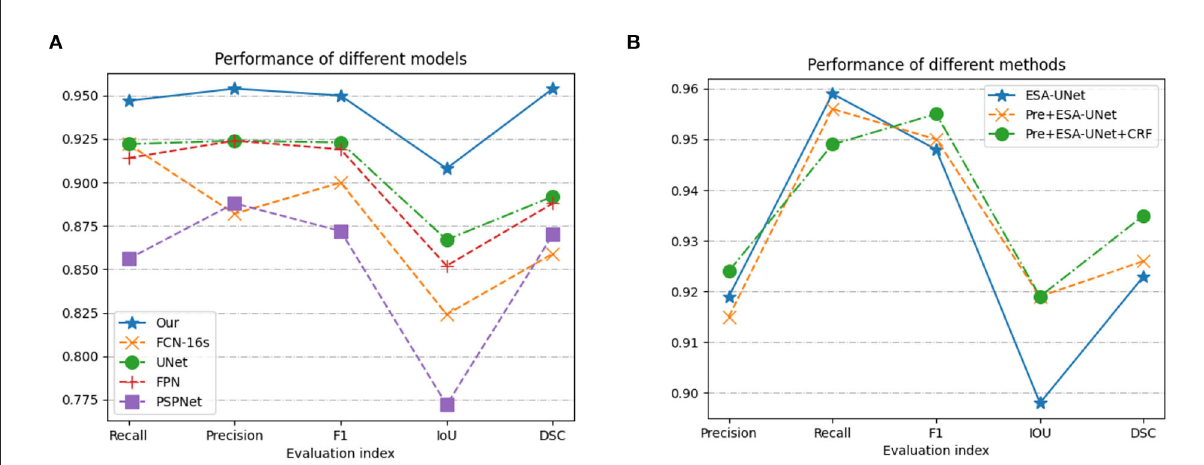
FIGURE5 Performance based on (A) model methods on different indicators; and (B) three methods combination